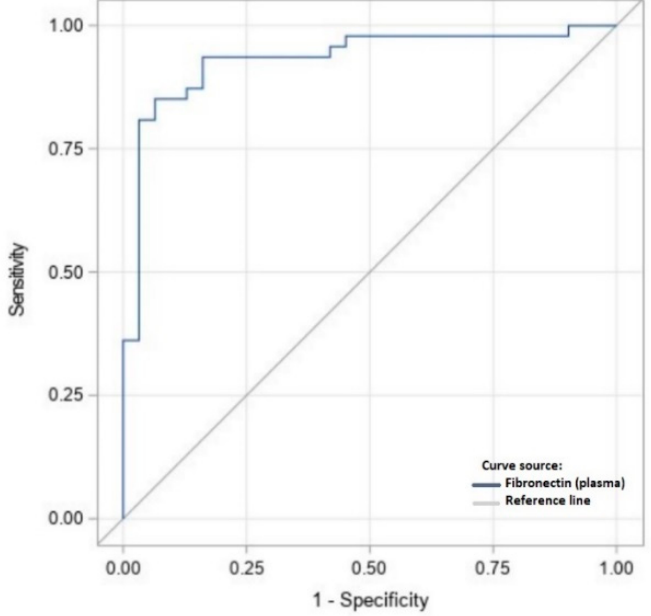
Figure 2. The ROC curve analysis for diagnostic efficacy of fibronectin in peritoneal fluid for endometriosis.